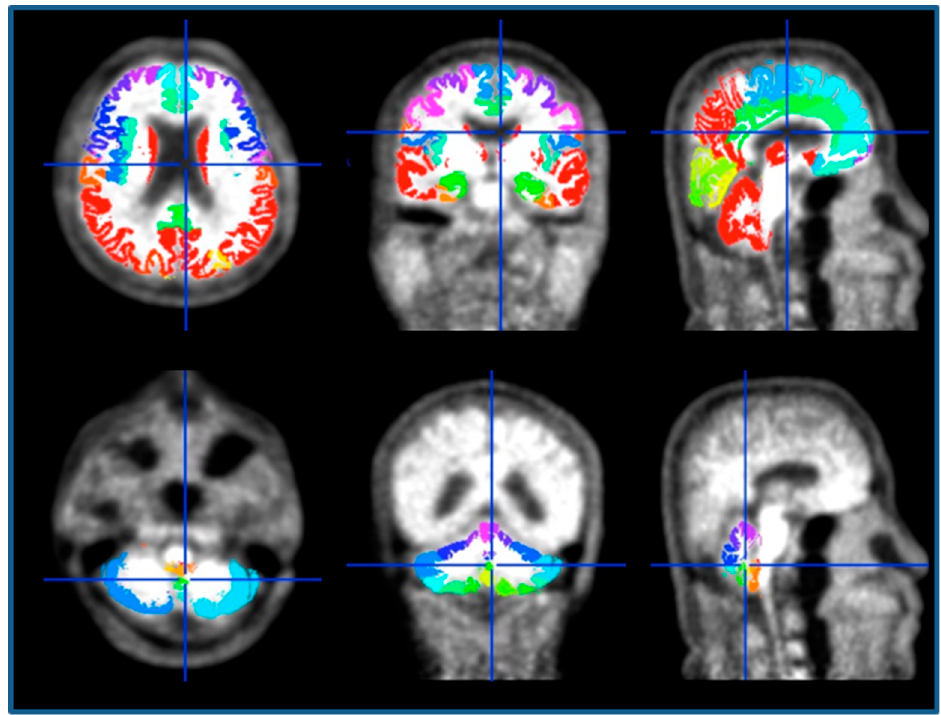
Figure A1. Representative images of regions of interest based on Automatic Anatomic Labeling (AAL) for individual 11 C-PiB-PET data. Using the published list of automatically labeled regions [19], the frontal regions of interest (ROIs) included bilateral frontal, anterior cingulate, middle cingulate, and insular cortex regions (region 3–34); the posterior cingulate-precuneus ROIs included bilateral regions (region 35;36) and (region 67;68); the lateral temporal ROIs included bilateral regions (region 79–90); the lateral parietal ROIs included bilateral regions (region 59–65); the basal ganglia ROIs included bilateral caudate, putamen, and globus pallidus regions (region 71–76); the medial temporal ROIs included bilateral hippocampus, parahippocampal gyrus, and amygdala regions (region 37–42); and the cerebellar reference ROIs included bilateral cerebellar crus I regions (region 91;92) [21].